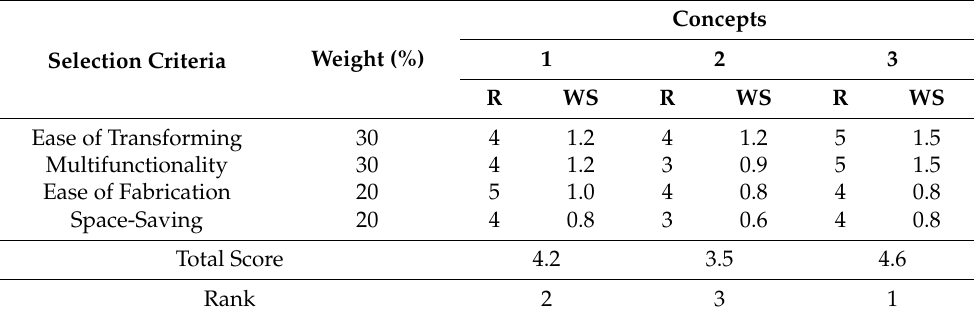
Table 4. Concept scoring.